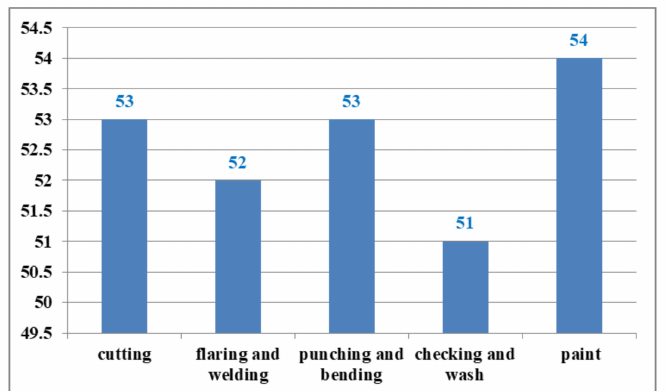
Figure 8. Improved cycle time of each satellite dish kit (after improvement, units: second).